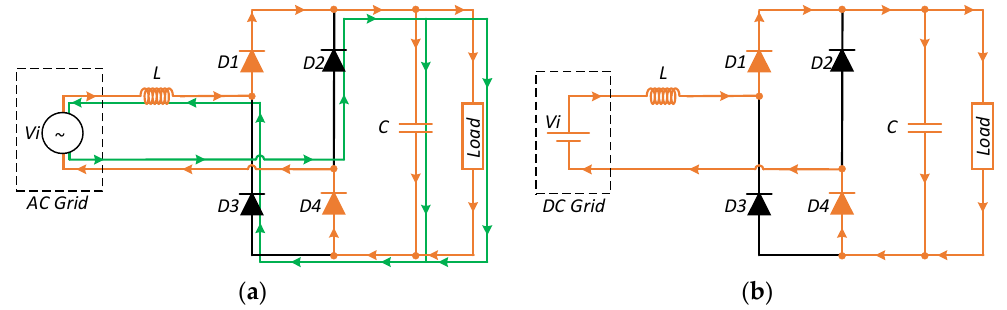
Figure 8. Typical rectifier used in AC electronic loads: ( a ) connection to an AC socket and ( b ) connection to a DC socket.